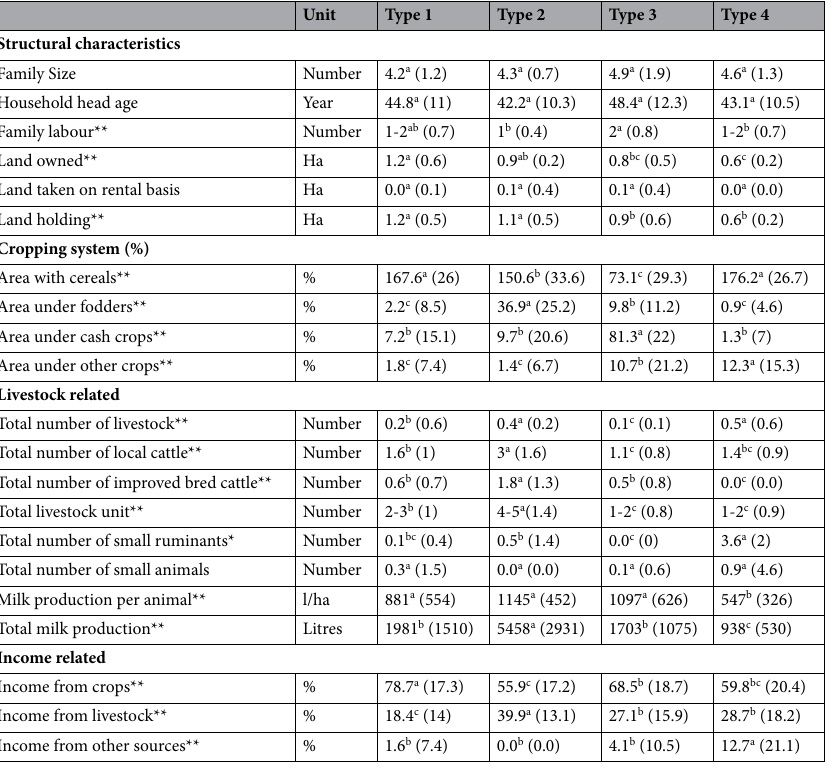
Table 2. Crop, livestock and income related characteristics of households under different farm types. As per Kruskal-Wallis test, variables denoted with * differ significantly with p < 0.05 and with ** differ very significant with p < 0.001. Data figures with different letter (a,b,c) are significantly different among means of 4 farm HH types. Figures in the parenthesis are standard deviation of